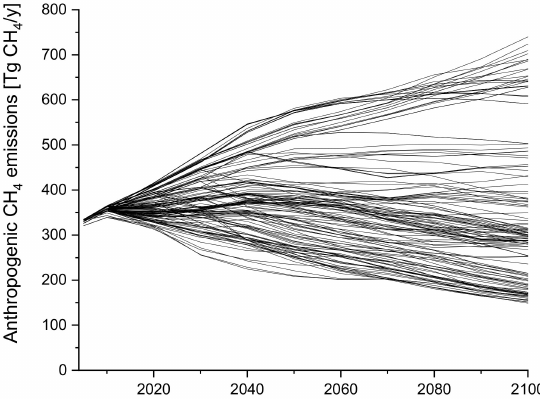
Figure 1. Anthropogenic methane emissions of IMAGE 2.4 and MESSAGE V.4 scenarios. Underlying data from the AR5 Scenario Database (v. 1.0.2) available at https: // tntcat.iiasa.ac.at / AR5DB /